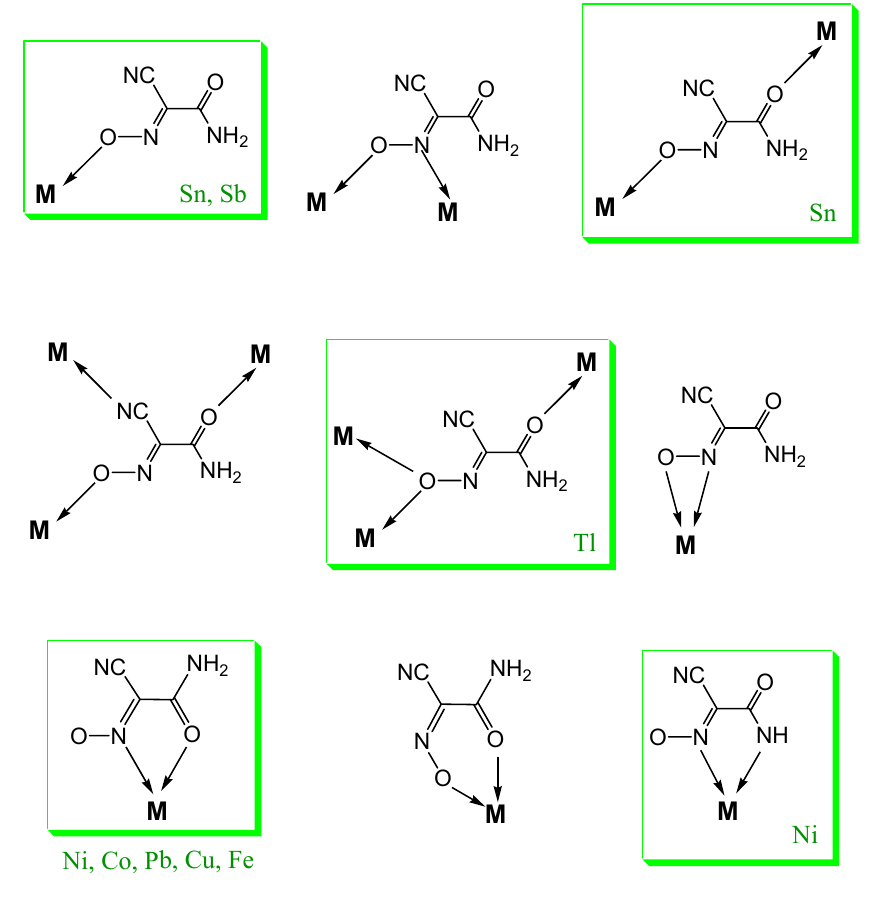
Figure 4. Some of the most probable binding modes of the acetamide-cyanoxime anion, ACO − . Framed structures with cited metals were confirmed by the X-ray